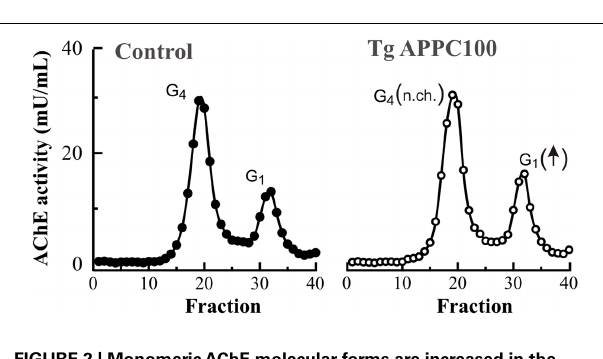
FIGURE 2 | MonomericAChE molecular forms are increased in the brain of a transgenic mouse model ofA β over-expression. AChE is expressed as several different species with various molecular weights which can be identified by sucrose density gradient centrifugation (see Figure 1 ). Cerebral cortices from an APPC100 transgenic mice which express human A β (Tg APPC100; open circles) display higher levels of monomeric G 1 AChE forms compared to control samples of similar age (closed circles; 3months old), while levels of tetrameric G 4 AChE species were not different (no change; n.ch.). See also Sberna et al. (1998).